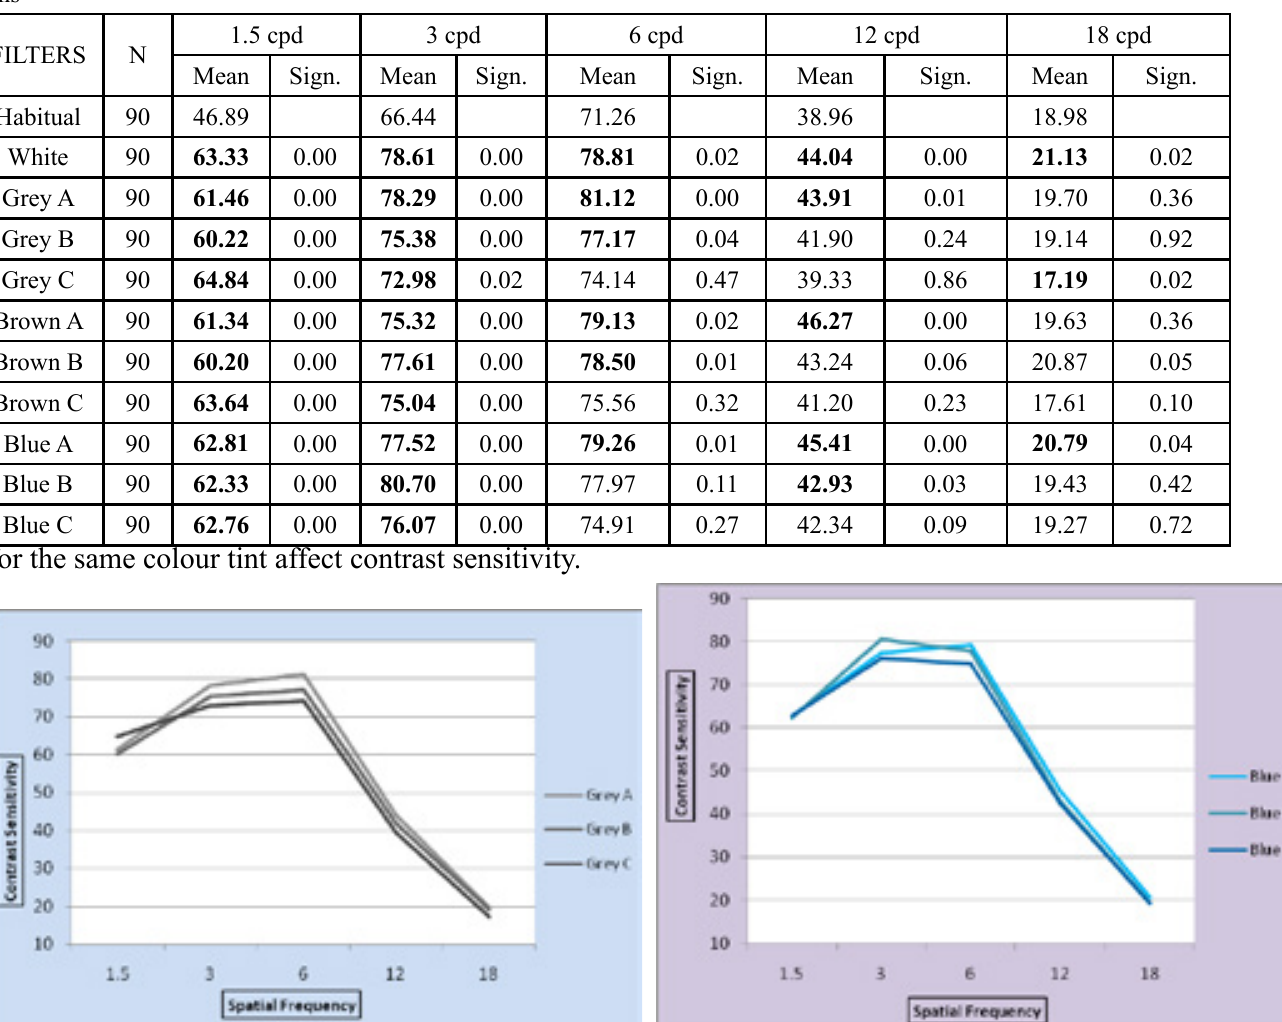
Figure 4: Contrast sensitivity functions of the varying densities (A, B and C) of the blue